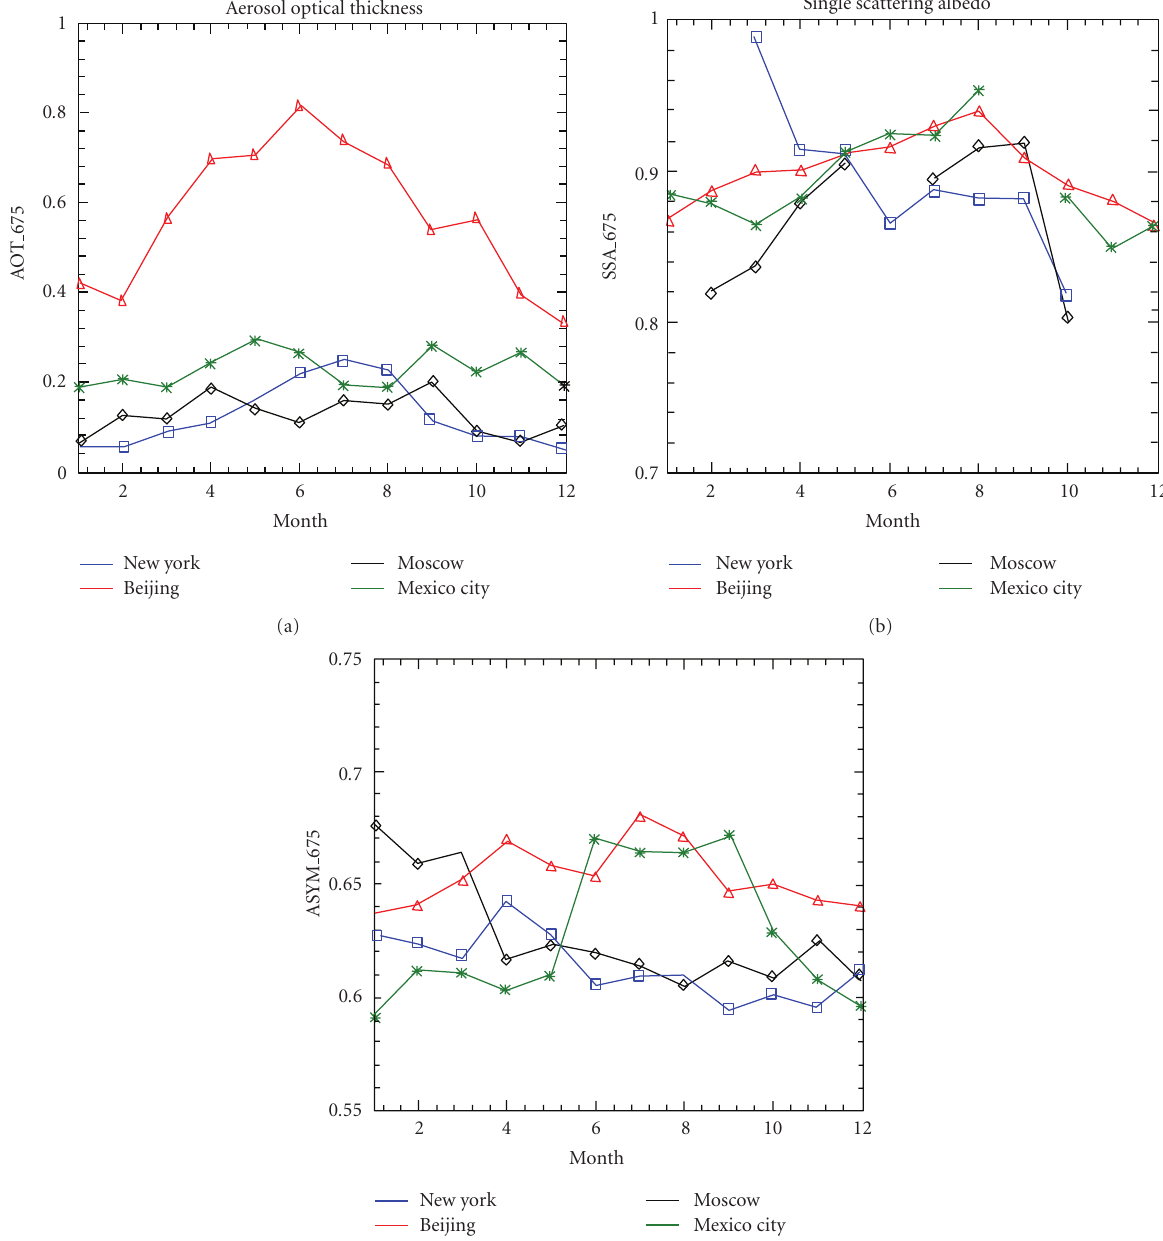
in the 0.7 range and cloud drops that are larger, compared to the wavelength, are more typically 0.85. Together with AOT and single scattering albedo, this parameter is useful for obtaining the basic radiative properties of aerosols. In the summer, Beijing and Mexico City have higher asymmetry factors than NYC and Moscow, which means that aerosol particles over Beijing and Mexico City are larger than those over